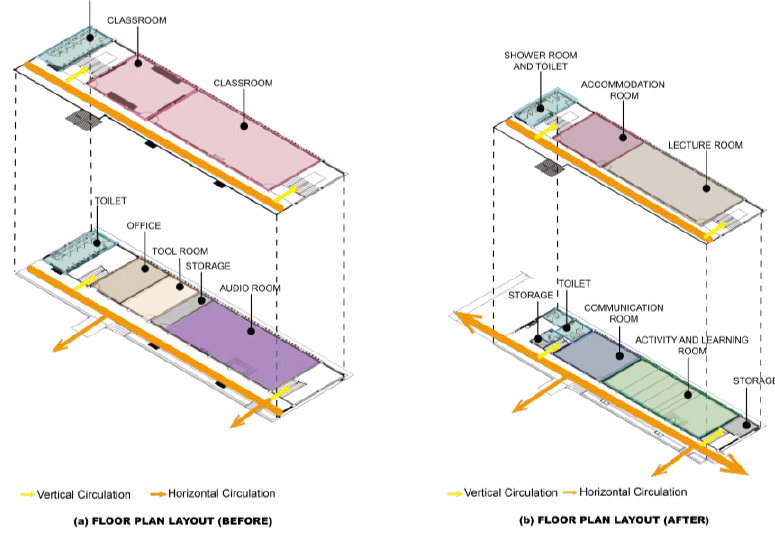
Figure 5. Floor Plans: ( a , b ) Checheng Elementary School Wencyuan Branch Floor Plans.